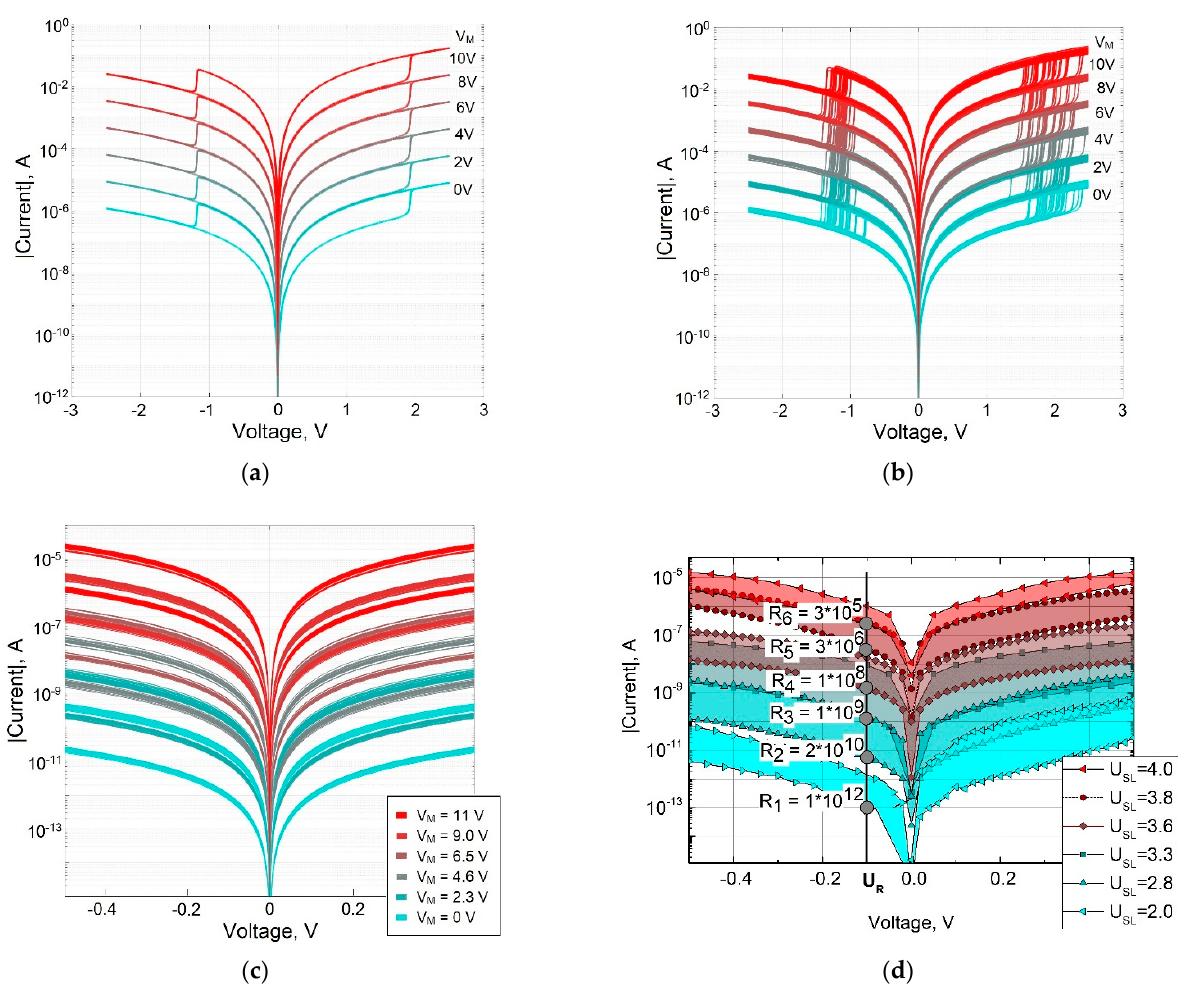
Figure 8. I–V characteristics of a memristive element with multilevel conductivity tuning without taking into account ( a ) and taking into account ( b ) the statistical variation of parameters, comparison of the simulation results ( c ) with the measurement data ( d ) [27] for the memristive structure shown in Figure 2b (measurements were carried out for one sample of the memristor structure).